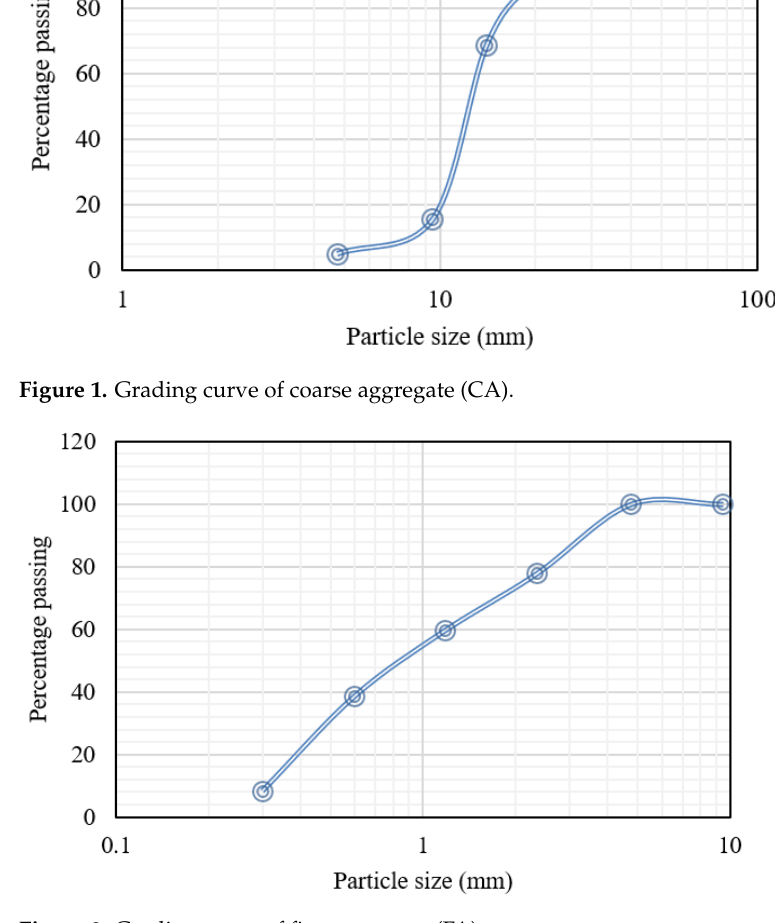
Figure 2. Grading curve of fine aggregate (FA).